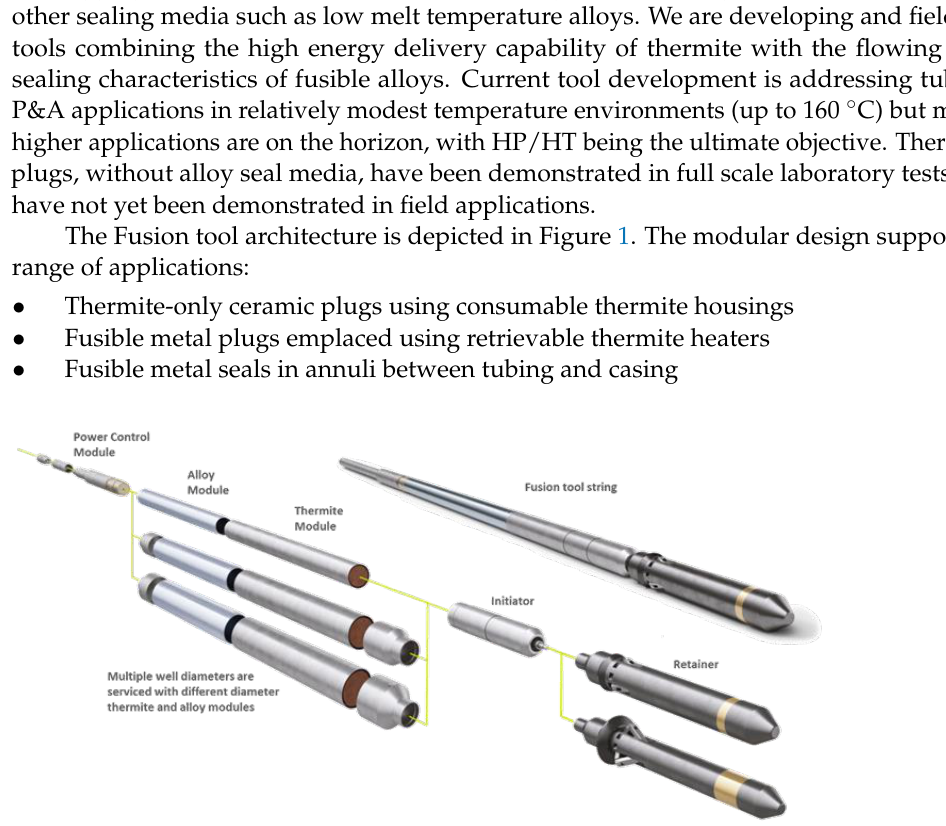
Figure 1. Fusion tool string showing modular design which addresses different well diameters for fusible metal alloy emplacements. For thermite-only plugs, the alloy modules are not included. The Fusion tool is emplaced via wireline, slickline, or coiled tubing, and the control system permits autonomous or surface-controlled operation. If needed, a retainer module forms a fixed anchor platform upon which the plug forms (not necessary if the plug is placed above bridge plugs, cement platforms, or